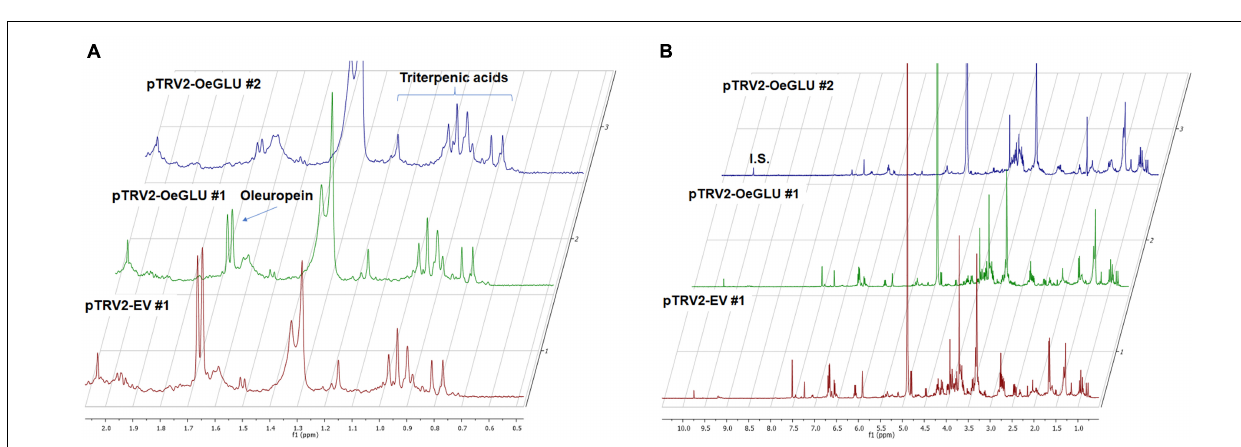
FIGURE 6 | Representative 1D-qNMR spectra. Comparison between the methanolic extracts of plants Agroinoculated with pTRV2-EV and pTRV2-OeGLU constructs for their triterpenic acids content (A) or their full spectrum (B) . Numbers indicate biological replicates. EV, empty vector; IS, internal standard; OeGLU, oleuropein β -glucosidase; 1D-qNMR, one-dimensional quantitative nuclear magnetic